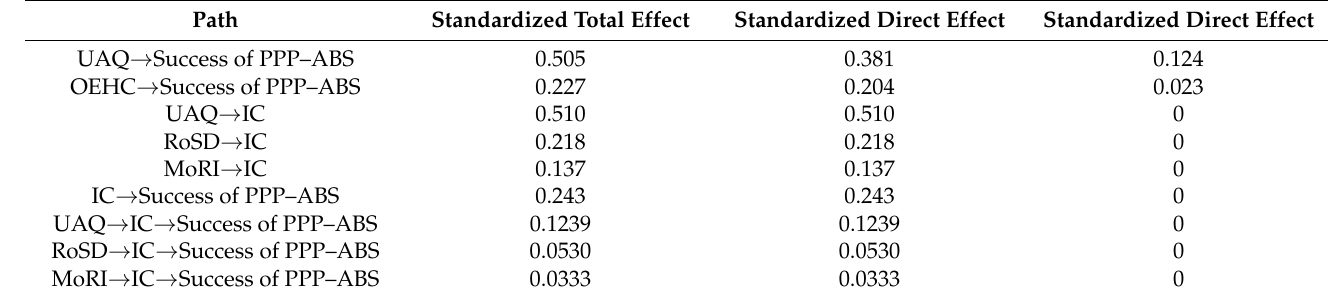
Table 8. Results of mediating effect (Source: Authors’